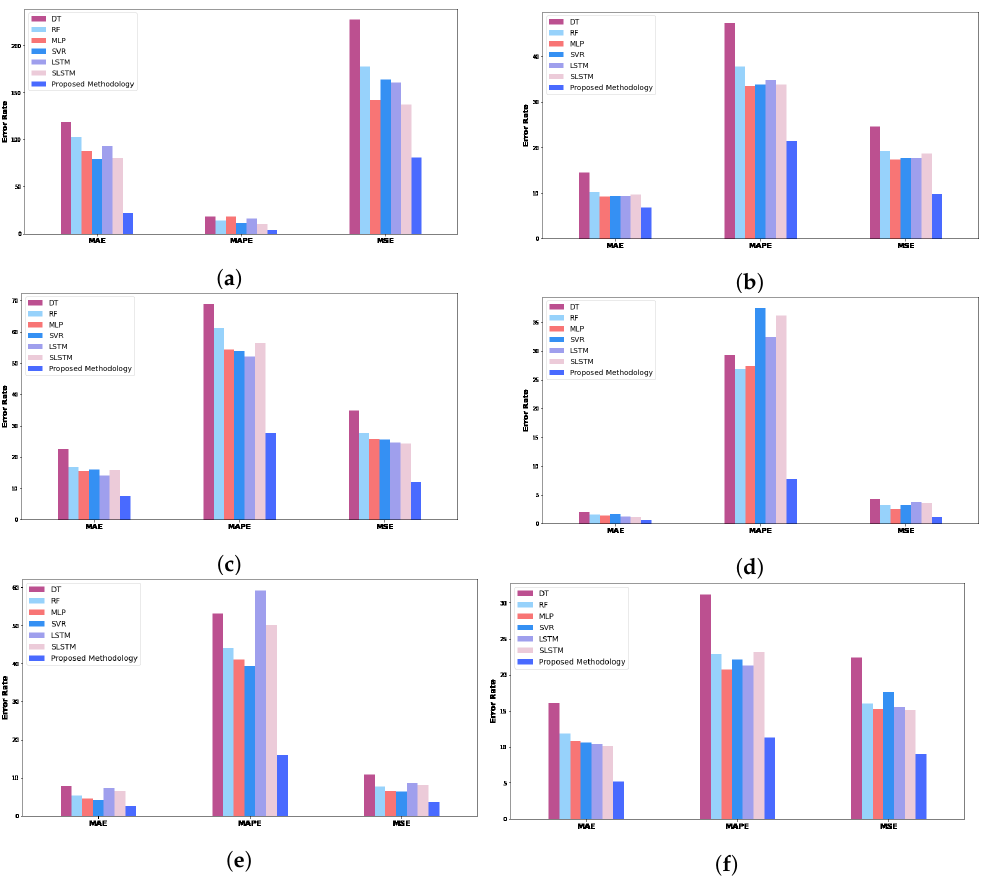
Figure 7. Comparison Analysis of Proposed Framework prediction results with State-of-the-art Frameworks for ( a ) CO , ( b ) PM 2.5 , ( c ) PM 10 , ( d ) SO 2 , ( e ) NO 2 and ( f ) O 3